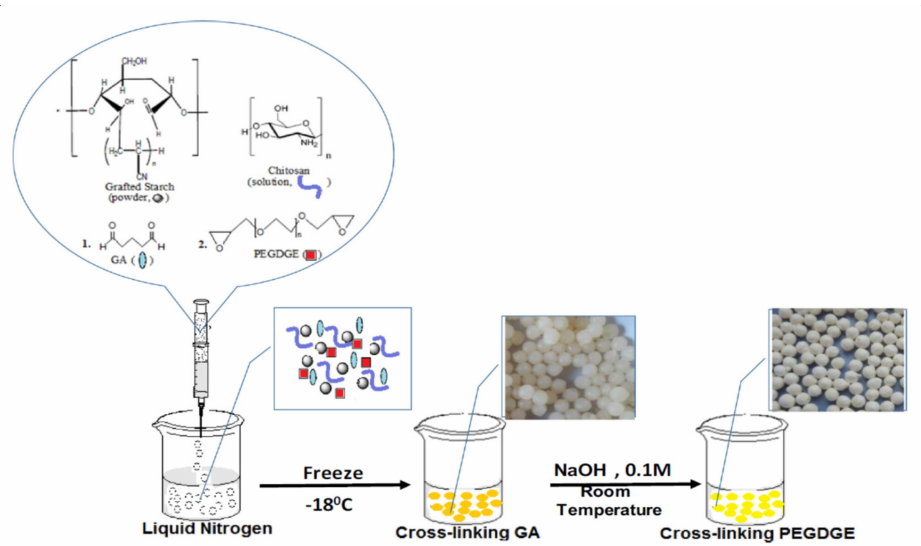
Figure 5. Composite cryobeads based on CS and starch (reprinted with permission from ref.